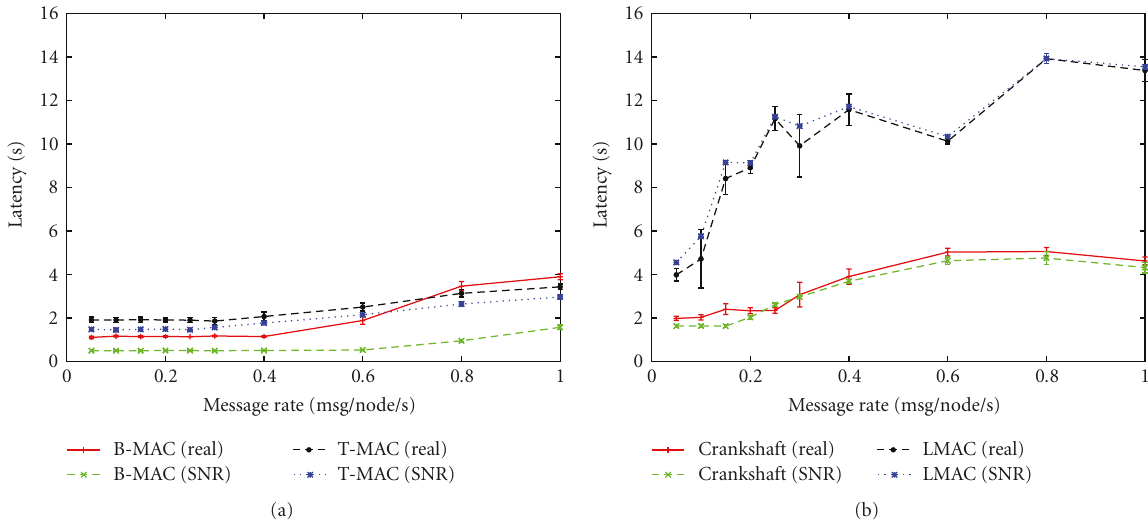
Figure 8: Average packet latency for simulated and real convergecast experiments. with the sink at the edge of the network.